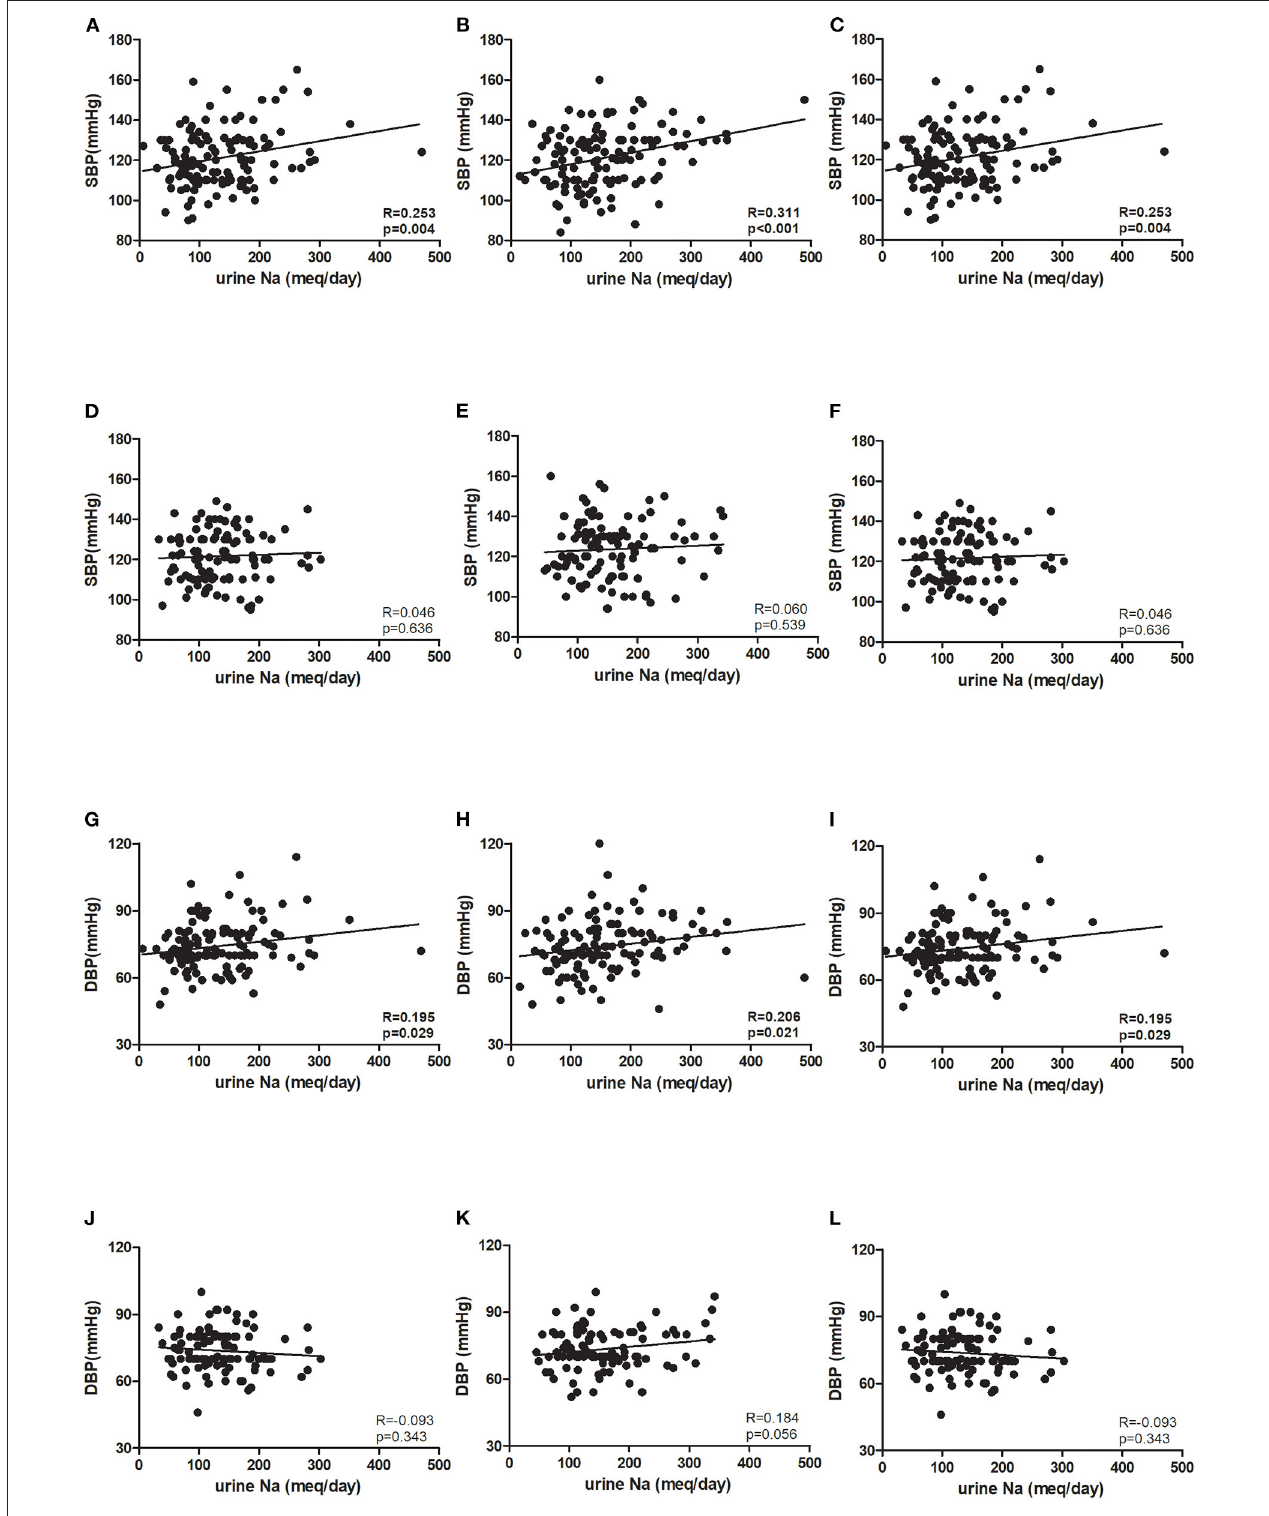
FIGURE 4 | Association between blood pressure and urine sodium in the ESPECIAL (Effects of Low Sodium Intake on the Antiproteinuric Efficacy of Olmesartan in Hypertensive Patients with Albuminuria) trial. Systolic blood pressure (SBP) at (A) 0 week (0w), (B) 8 weeks (8w), and (C) 16 weeks (16w) in the younger group. SBP at (D) 0w, (E) 8w, and (F) 16w in the older group. Diastolic blood pressure (DBP) at (G) 0w, (H) 8w, and (I) 16w in the younger group. DBP at (J) 0w, (K) 8w, and (L) 16w in the older group (R: correlation coefficient, p : p -value).